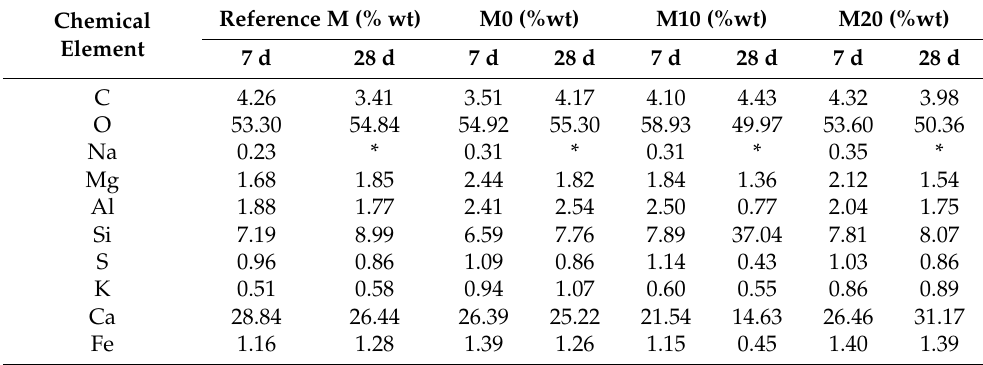
Table 5. EDX analysis for mortars produced with and without nanocomposite hydrogel.